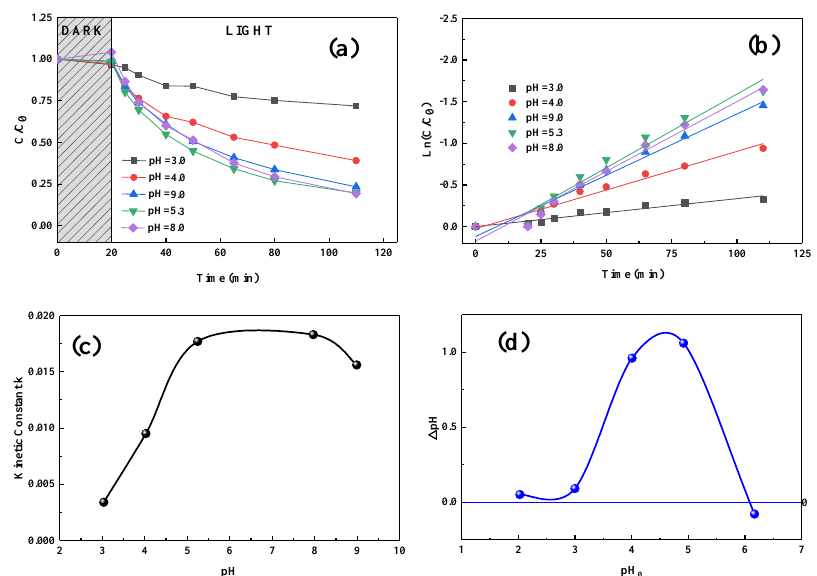
Figure 6. Effect of solution pH on BPA degradation under visible light irradiation. ( a ) curve of C/C 0 versus time; ( b ) corresponding ln(C/C 0 ) and time curve; ( c ) first-order kinetic constant curve of k versus catalyst concentration (BPA concentration = 0.01 mol/L, catalyst dosage = 0.5 g/L, volume of the solution = 100 mL, λ = 420 nm, 10 tubes); and ( d ) isoelectric point of 1% rGO–P25 composite